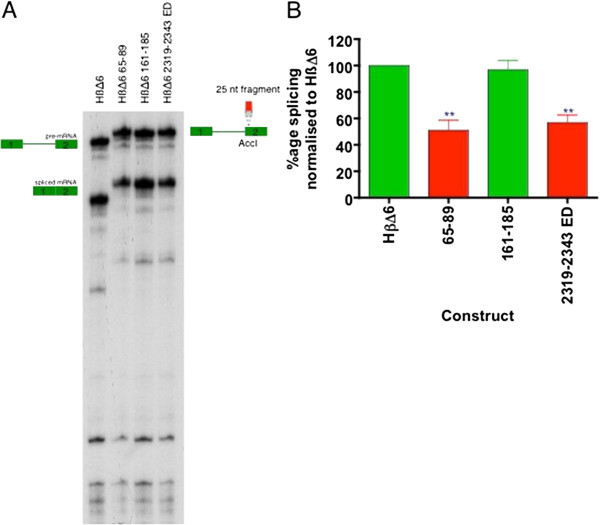
Structure of the DNA ligase III splicing reporter and in vitro splicing assay of exon 26 sequences. (A) Top Schematic showing the genomic structure of APOB exon 26 and adjacent exons. Boxes represent exons, the lines interconnecting exons represent introns. Numbers above exons and introns represent lengths of the respective elements in nucleotides. Exon 26 is divided into 400 nt fragments labelled 1 to 18. Note that fragment 19 is shorter than fragments 1–18 at 372 nt. Bottom shows fragment 5 in position at the 3′ end of the DNA ligase III splicing reporter, replacing the native ESS. (B) In vitro splicing of A constructs: 10% PAGE shown. Lanes M = pBR322-MspI digest marker; Cß = DNA ligase III C-ß construct without ESS; I3+4 = DNA ligase III C-ß with IGF-I exons 3 and 4 tagged to 3′ end; 1–19 = fragment 1 to 19 constructs. Adjacent cartoons show identity of bands. Note that the migration of the splicing intermediates of the DNA ligase III C-ß reporter is characteristically retarded on this high percentage gel. (C) Graph showing relative splicing efficiency of constructs, normalised to 100% = splicing efficiency of DNA ligase III C-ß construct without ESS.